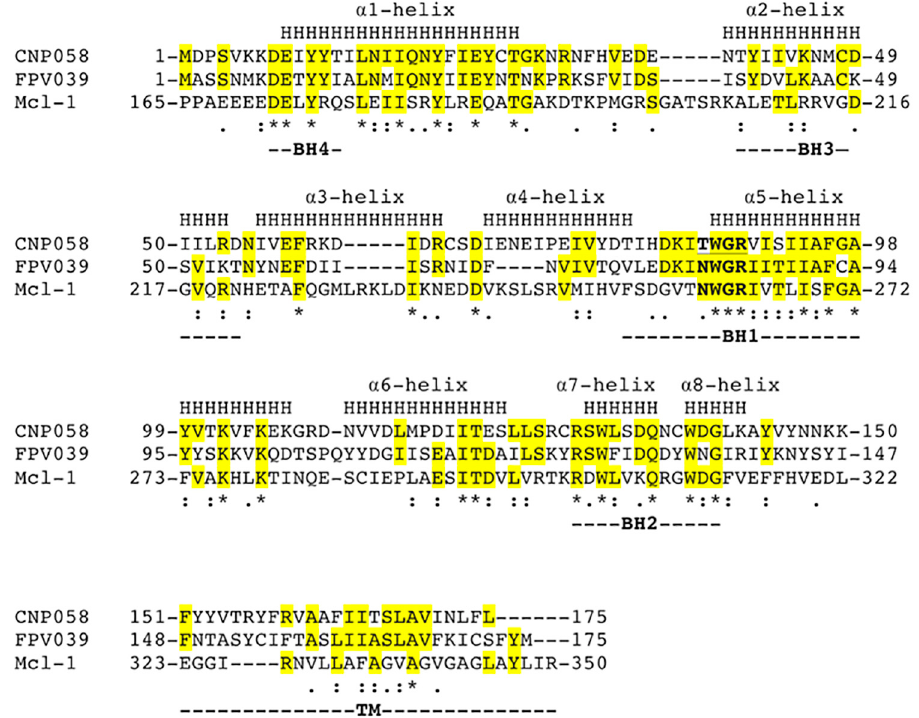
Figure 3. Structure based sequence alignment of CNP058 with FPV039 and cellular Bcl-2 protein Mcl-1. The α -helical secondary structure elements indicated (denoted as H and labeled as Helix 1–8) are based on the crystal structure of CNP058. Bcl-2 homology domains (BH domains) 1–4 are marked underneath the aligned sequences. Conserved residues are highlighted in yellow. “*” denotes conserved residues for all three proteins, “:” denotes highly similar residues between the three proteins, and “.” denotes weakly similar residues between the three proteins. The NWGR or TWGR motifs are marked in bold. Uniprot accession codes: CNP058 = Q6VZT9, FPV039 = Q9J5G4 and Mcl-1 = Q07820; PDB accession codes: FPV039 = 5TZP and Mcl-1 = 2NL9.